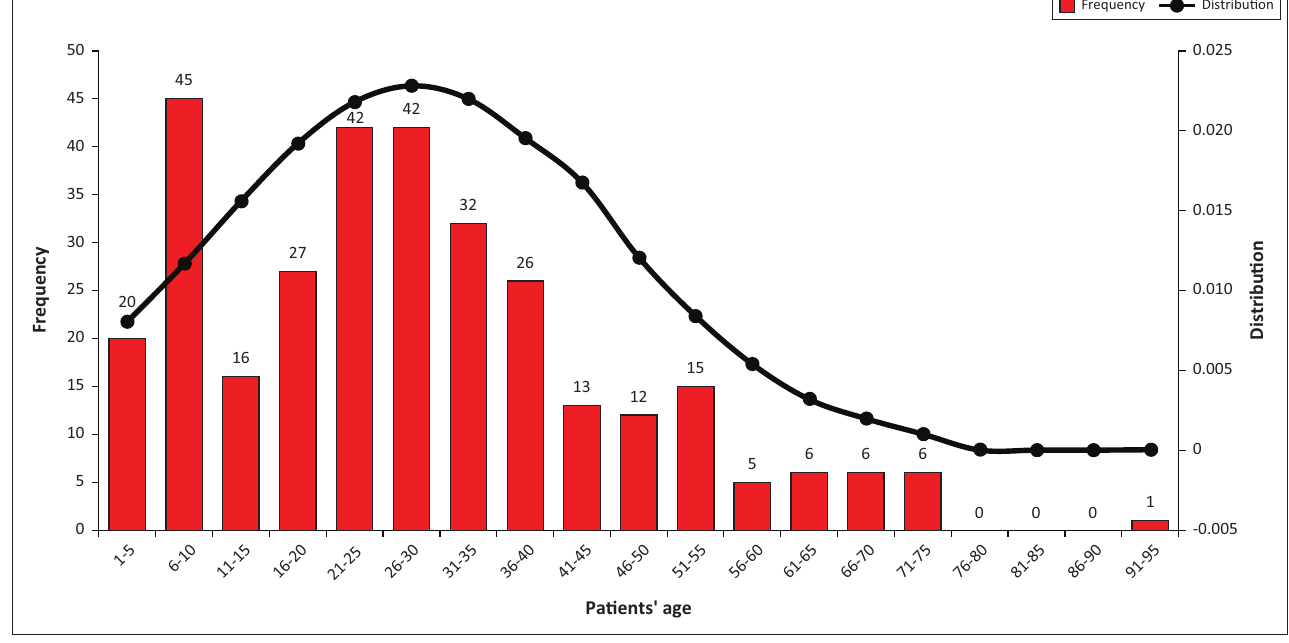
FIGURE 2: Frequency and distribution of patients’ age.